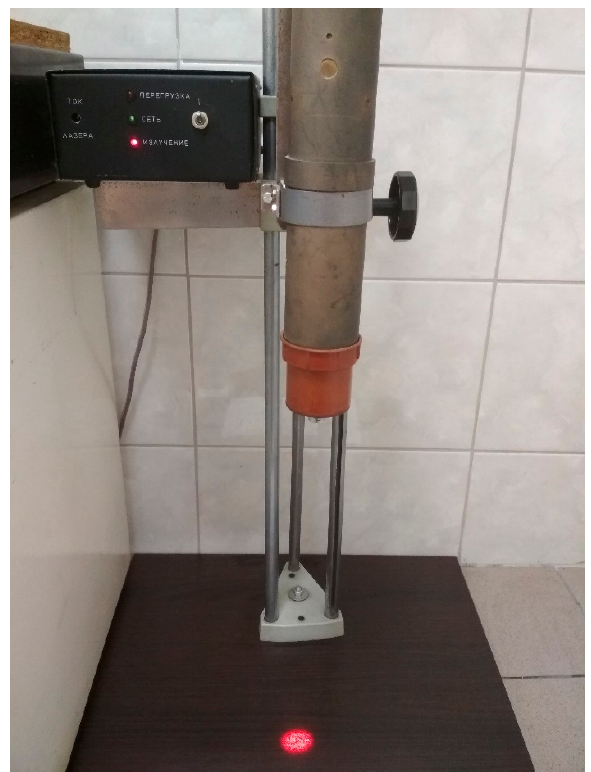
Figure 1. Device for stimulating seeds with He–Ne laser light.